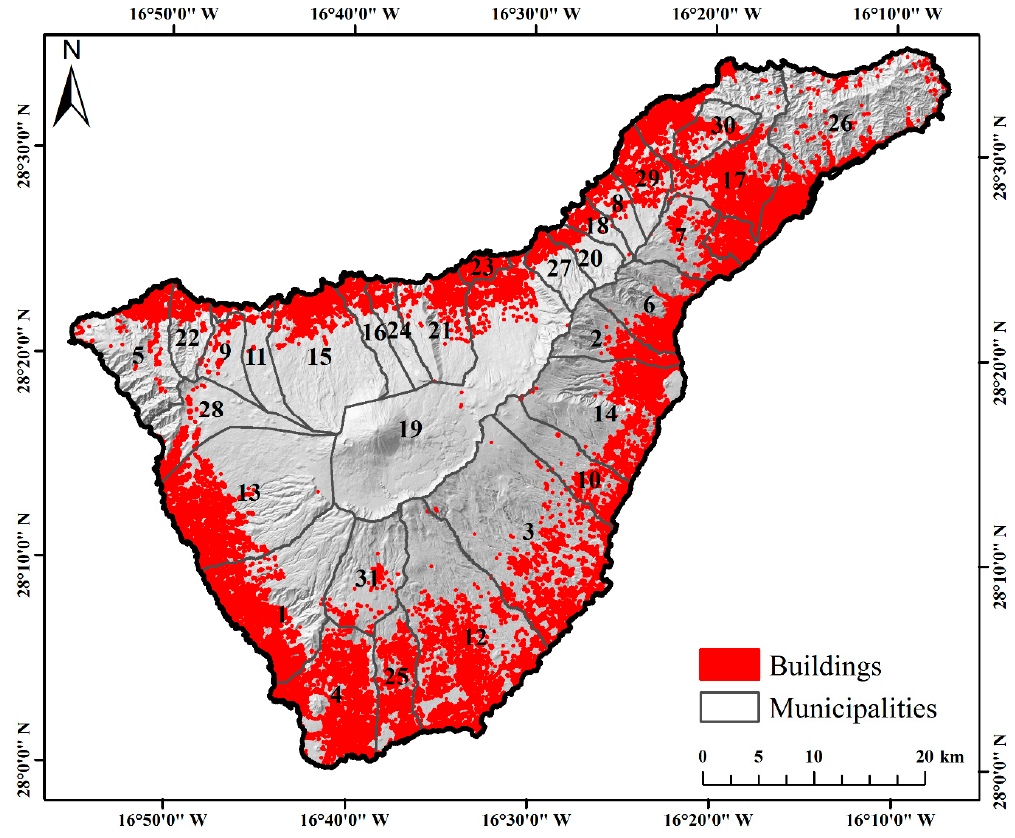
Figure 3. The distribution of buildings on Tenerife, extracted by random forest classification.